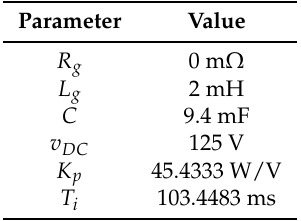
Table 1. Parameters of the 7 kW DFIG grid filter, DC bus, and v DC I-P regulator.